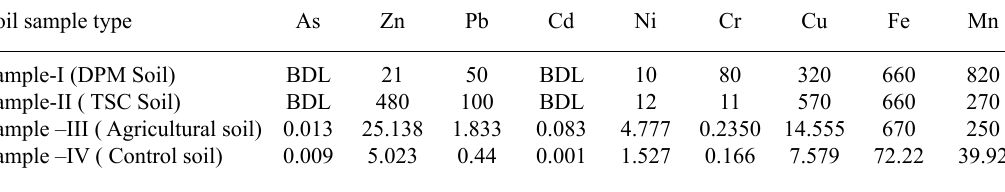
Fig. 2. Atomic Absorption Spectrum (AAS - table 1. Heavy metal analysis data (Atomic Absorption spectrum)